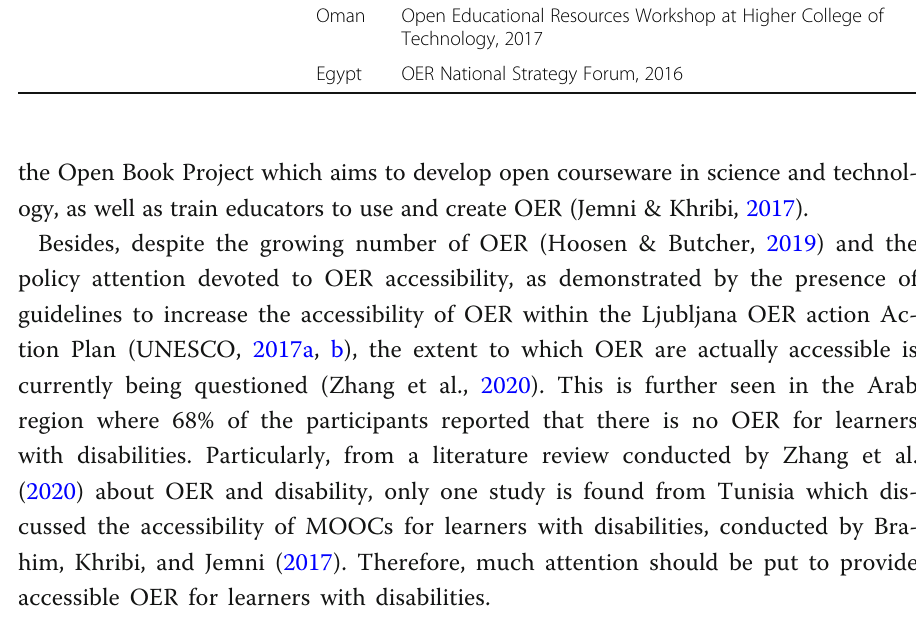
Table 2 OER initiatives in the Arab world (Continued) Initiative category Country Initiative Organizing e-learning trainings and OER